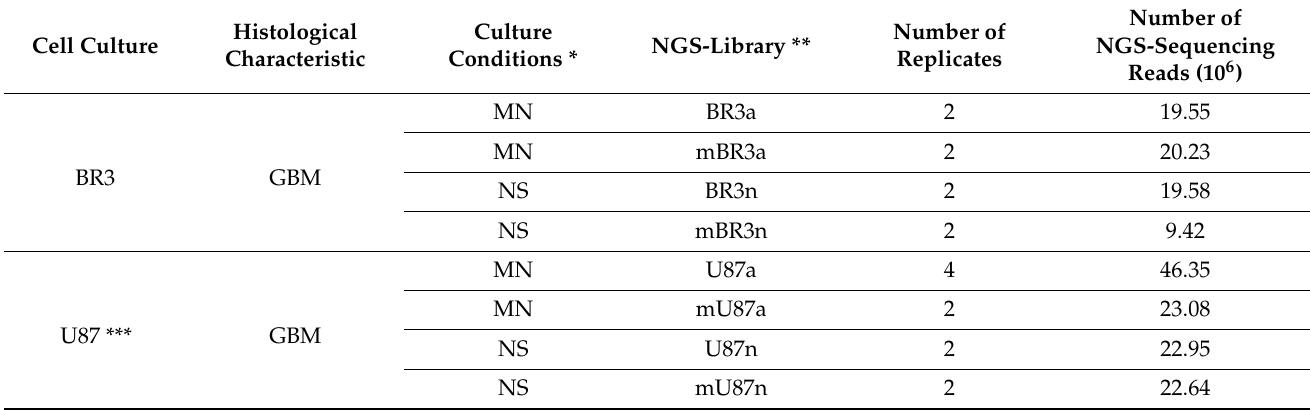
Table 1. Characteristics of human GBM cell cultures and RNA sequencing